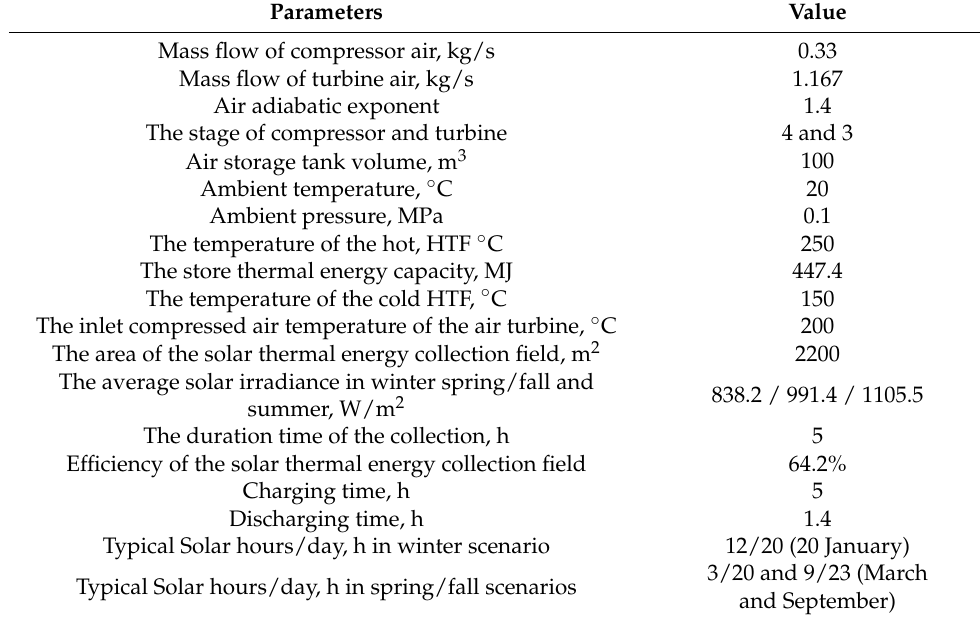
Table 1. The designed parameters of the SA-CAES system.